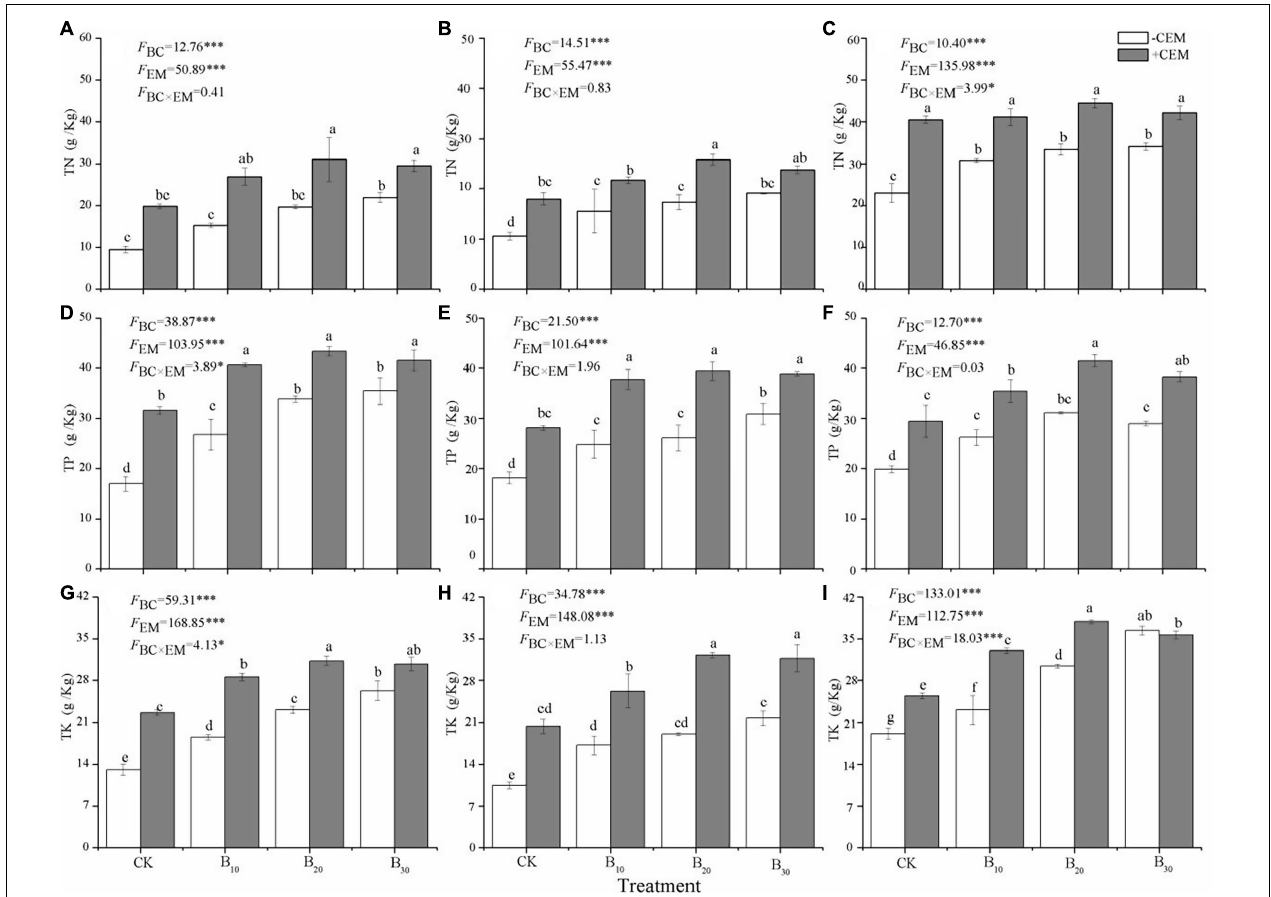
FIGURE 3 | Root TN (A) , shoot TN (B) , leaf TN (C) , root TP (D) , shoot TP (E) , leaf TP (F) , root TK (G) , shoot TK (H) , and leaf TK (I) under different treatments. TN, total nitrogen; TP, total phosphorus; TK, total potassium. Different lowercase letters referred to significant difference between treatments ( p < 0.05). The F BC , F CEM , and F BC × CEM are F and the degree of freedom of two-way ANOVAs. ∗∗∗ p < 0.001 and ∗ p <